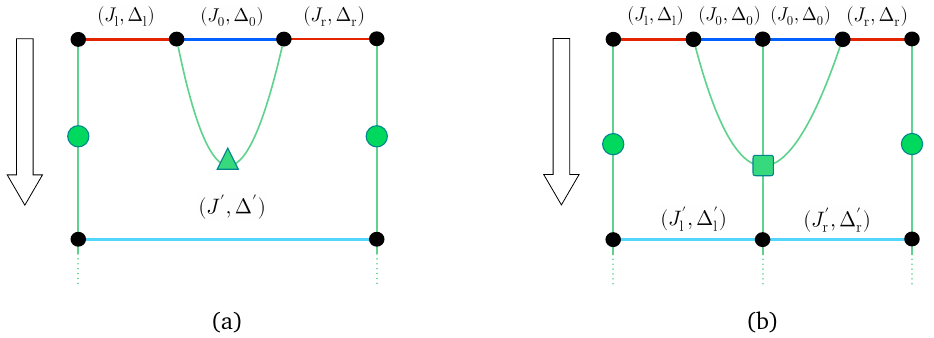
Figure 10: Tensor representation of the fundamental SDRG transformations previ- 〉 in (65) are depicted ously introduced in Fig. 5. Tensors associated to the states | T n as green circles ( n = 1), triangles ( n even) and squares ( n (cid:54) = 1 odd), with the green legs representing their indices. The spins σ are contracted with the identity ten- l,r 〉 and remain unchanged. a) Decimation of a 2-spin singlet by sor associated to | T 1 〉 . b) Decimation of a contracting the 2 spins with the rank-2 tensor associated to | T 2 〉 . 3-spin doublet by contracting the 3 spins with the rank-4 tensor associated to | T 3 For clarity, we will drop the green squares, triangles and circles in the following fig- ures of